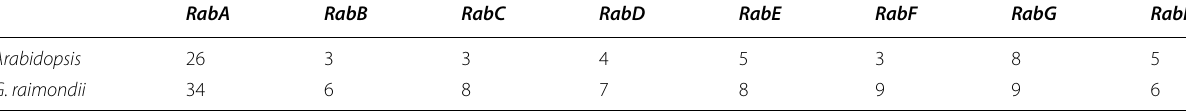
Table 2 The numbers of Rab genes of the eight groups between Arabidopsis and G. raimondii RabA RabB RabC RabD RabE RabF RabG RabH Arabidopsis 26 3 3 4 5 3 8 5 G. raimondii 34 6 8 7 8 9 9